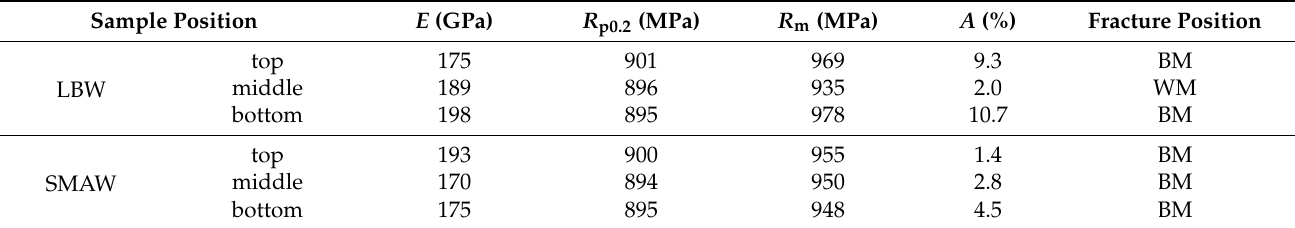
Table 5. Results of the Charpy impact